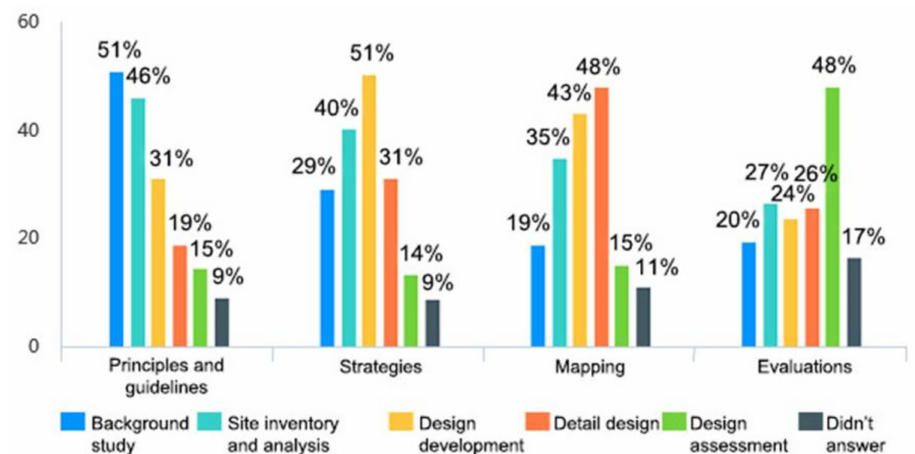
Figure 7. Question 6. The microclimatic design methods in different design stages.